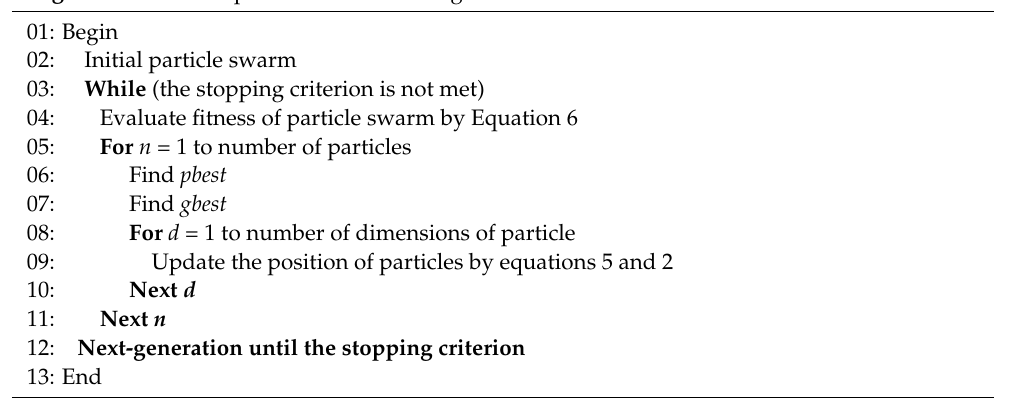
Algorithm 1. The steps of the DBM-PSO